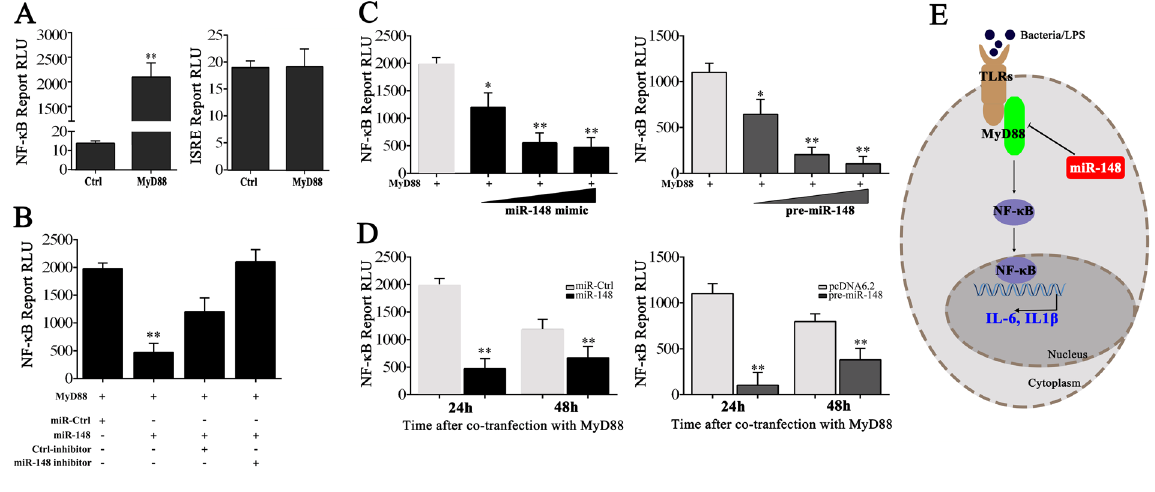
Figure 5. miR-148 suppresses MyD88-mediated NF- κ B pathway. ( A ) HEK293 cells were transfected with MyD88 expression plasmid, together with luciferase reporter constructs driven by NF- κ B, and ISRE reporter genes. After 24 h, the luciferase activity measured and results were presented relative to the luciferase activity in control cell. ( B ) miR-148 or miR-Ctrl and miR-148 inhibitor or Ctrl-inhibitor was transfected with MyD88 expression plasmid, together with luciferase reporter NF- κ B into HEK293 cells, each assay was transfected within equal amount of oligonucleotides. After 24 h, the luciferase activity measured. ( C , D ) A concentration and time gradient experiment were performed for miR-148 mimics and pre-miR-148 plasmid. ( E ) A proposed model for miR-148 of inflammatory cytokine secretion via miiuy croaker MyD88. The relative luciferase activity value was achieved against the renilla luciferase control. Data was presented as the means ± SE from three independent triplicated experiments. ** p < 0.01; * p < 0.05 versus the controls.